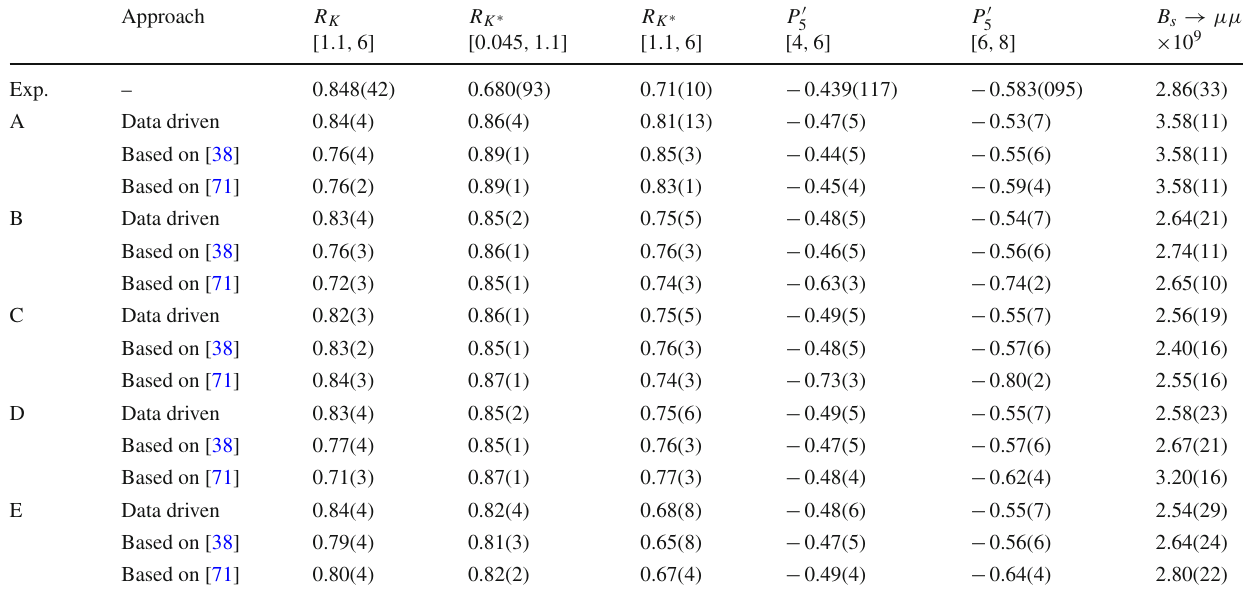
only; scenario C to NP contributions to C 10 only; scenario D to NP contributions to C LQ and C Qe ; and scenario E to NP contributions to 2223 2322 , C Qe , C Ld C LQ and C ed 2223 2322 2223 2223